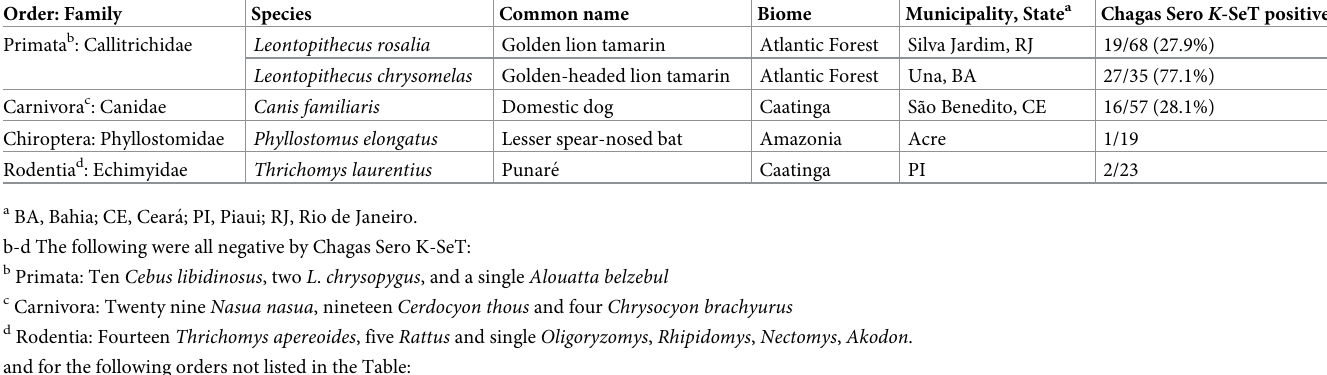
Table 2. Chagas Sero K -SeT RDT serological surveillance for TcII/V/VI natural infections among Brazilian mammal species. Order: